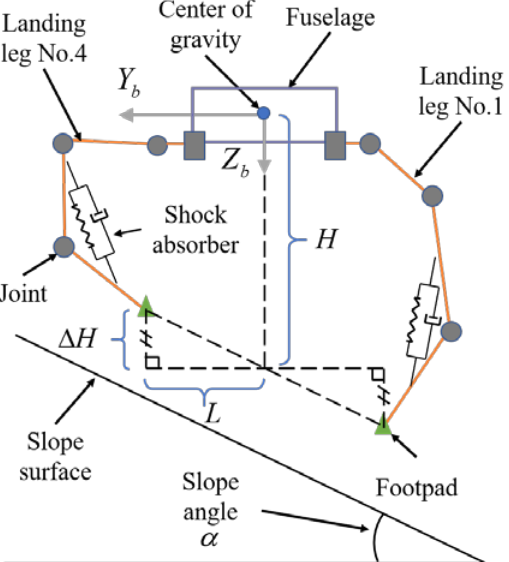
Figure 6. Schematic diagram of the control strategy for adjusting landing legs to adapt to complex landing terrains.